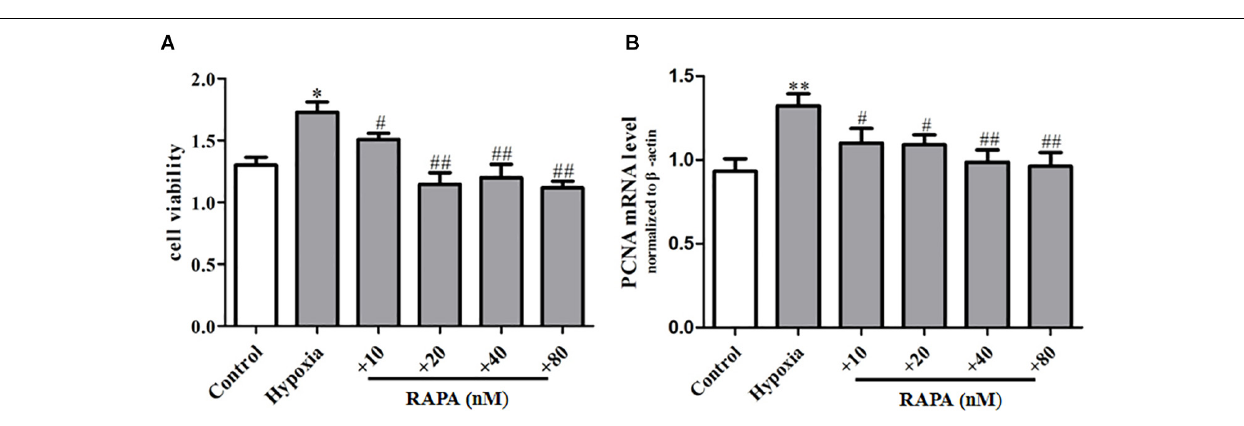
FIGURE 5 | Rapamycin can inhibit hypoxia-induced PASMC proliferation. (A) The proliferation ability of PASMCs was measured by CCK8 assay. (B) The mRNA expression of proliferative marker protein PCNA was measured by qPCR. Control: cells were treated with 21% O 2 for 48 h. Hypoxia: cells were treated with 3% O 2 for 48 h; + RAPA 10–80 nM: cells were treated with RAPA 10–80 nM and then subjected to 3% O 2 for 48 h, respectively. Data are mean ± SEM, n = 3. ∗ P < 0.05, ∗∗ P < 0.01, # P < 0.05, ## P < 0.01 vs.